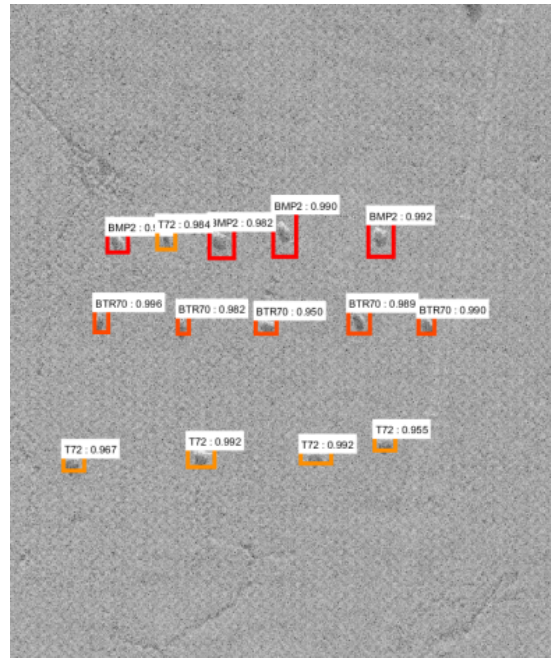
Figure 12. Interpretation result of a large simple scene SAR